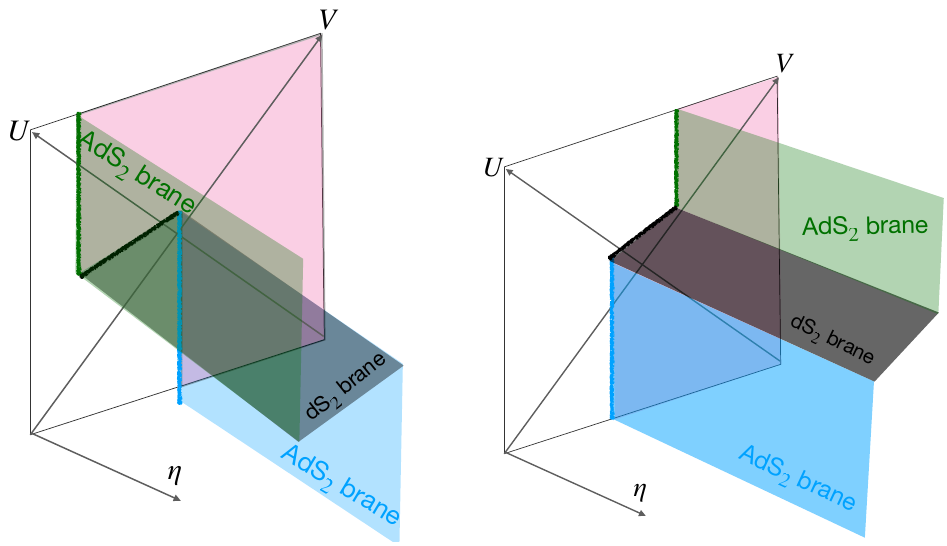
Figure 26 . The spacelike boundary in BCFT corresponds to inserting a dS brane with a tension |T | > 1 . Left: the expected bulk spacetime corresponding to a BCFT whose boundary follows a timelike-spacelike-timelike trajectory as in the case of the TST mirror. Right: another configuration that may mimic final state